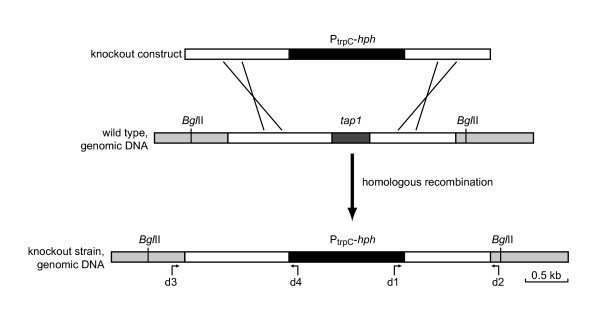
Strategy for the generation of a tap1 knockout strain. The tap1 open reading frame is shown in dark gray, flanking non-coding regions that are present in the knockout construct are given as white boxes, and adjoining regions not present in the knockout construct are shown in light gray. The Hygromycin B resistance cassette comprising the hph gene and the trpC promoter and 5' UTR is given in black. Positions of oligonucleotide primers d1 to d4 are indicated. For further information see text.